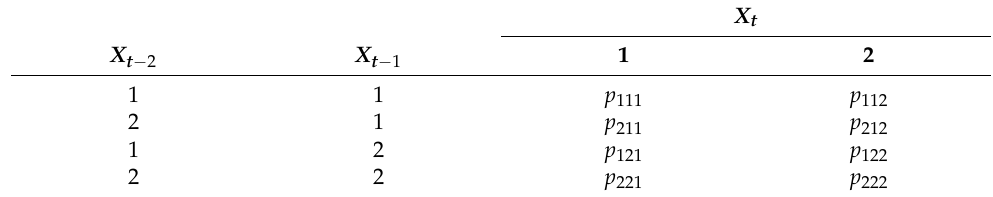
Table 1. Transition probability matrix of a second-order two-state Markov chain in reduced form.